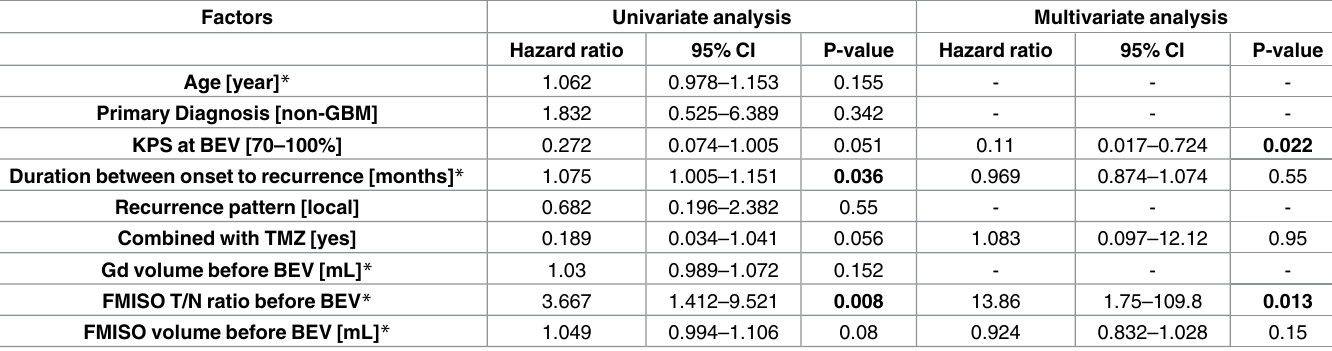
Table 2. Potential pre-BEV treatment predictors of overall survival in the patient recurrent high-grade glioma by BEV in Cox hazard model.